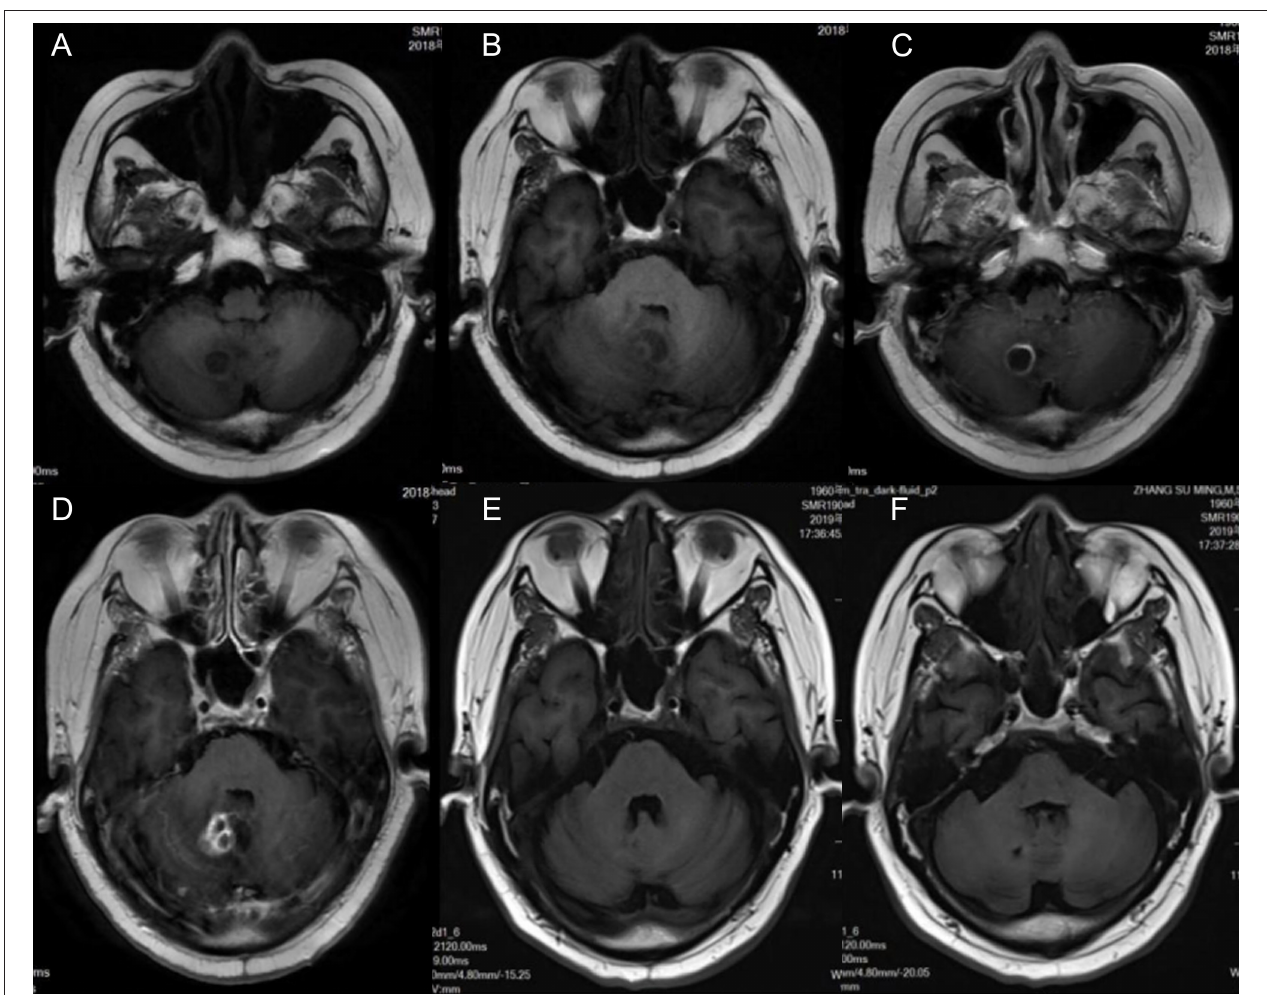
FIGURE 1 | Magnetic resonance imaging (MRI) of the patient shows cerebellar vermis and right cerebellar brain abscess with ring contrast enhancement and peripheral edema. (A,B) T1-weighted imaging. (C,D) Axial and sagittal T1 contrast enhancement imaging. (E,F) T1-weighted imaging 4 months after treatment; the lesion was reduced